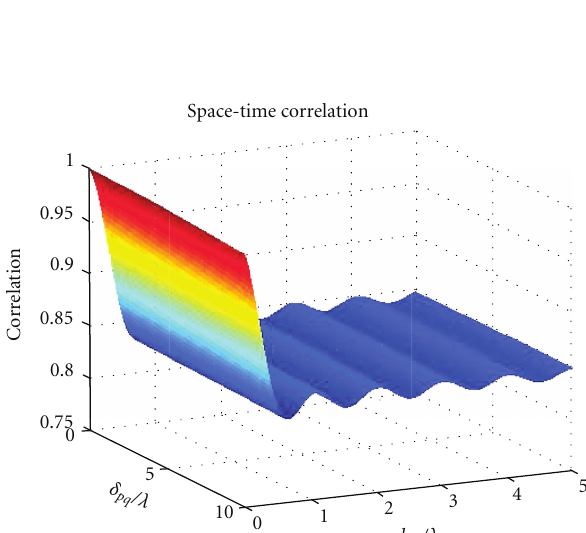
Figure 5: The space correlation when κ = 0.